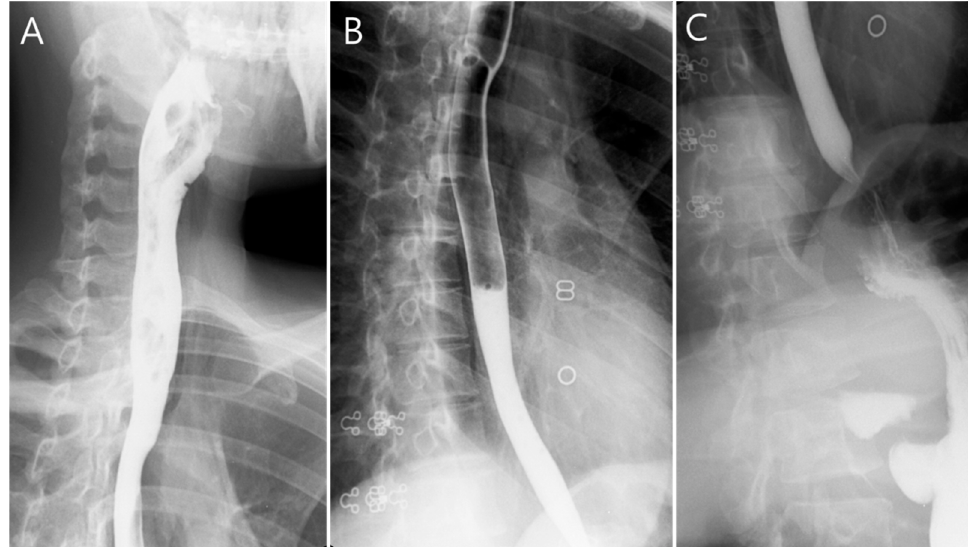
Figure 4. Upper gastrointestinal series revealed no obstruction and leakage at ( A ) upper, ( B ) middle, and ( C ) lower esophagus.